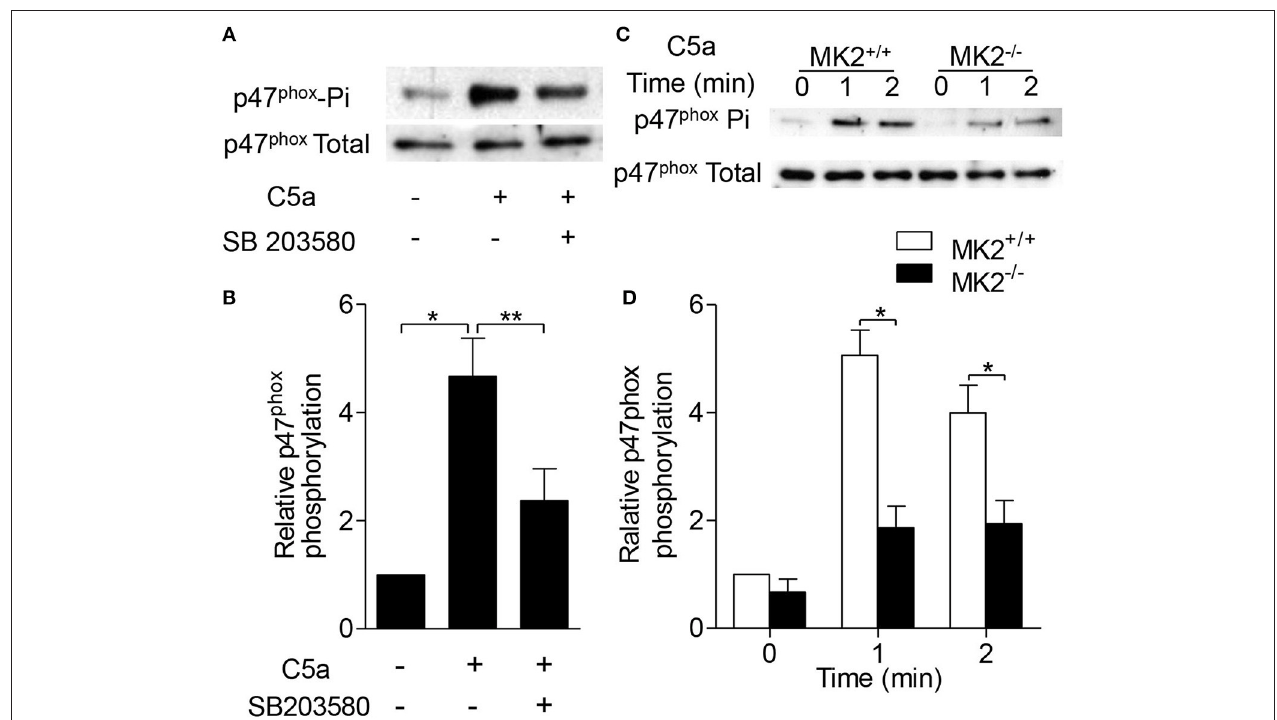
FIGURE 5 | MK2 was essential for p47 phox phosphorylation in response to C5a stimulation. (A) Neutrophils from WT mice were pre-treated with SB203580 (3 µ M) for 15min, and then stimulated with C5a (100nM) for 1min. The phosphorylation of p47 phox was determined. (B) Densitometry analysis was conducted to determine the 47 phox phosphorylation. (C) Neutrophils from MK2 + / + and MK2 − / − mice were stimulated with C5a (100nM) for 1 and 2min. The phosphorylation (Phospho)